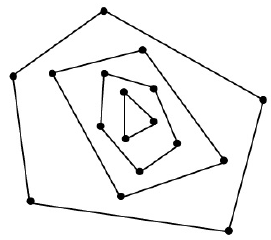
Figure 1: Convex layers of a point